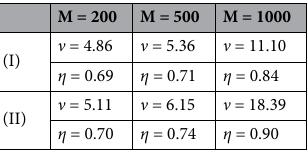
Table 1. Visibility ( ν ) and reconstruction efficiency ( η ) .